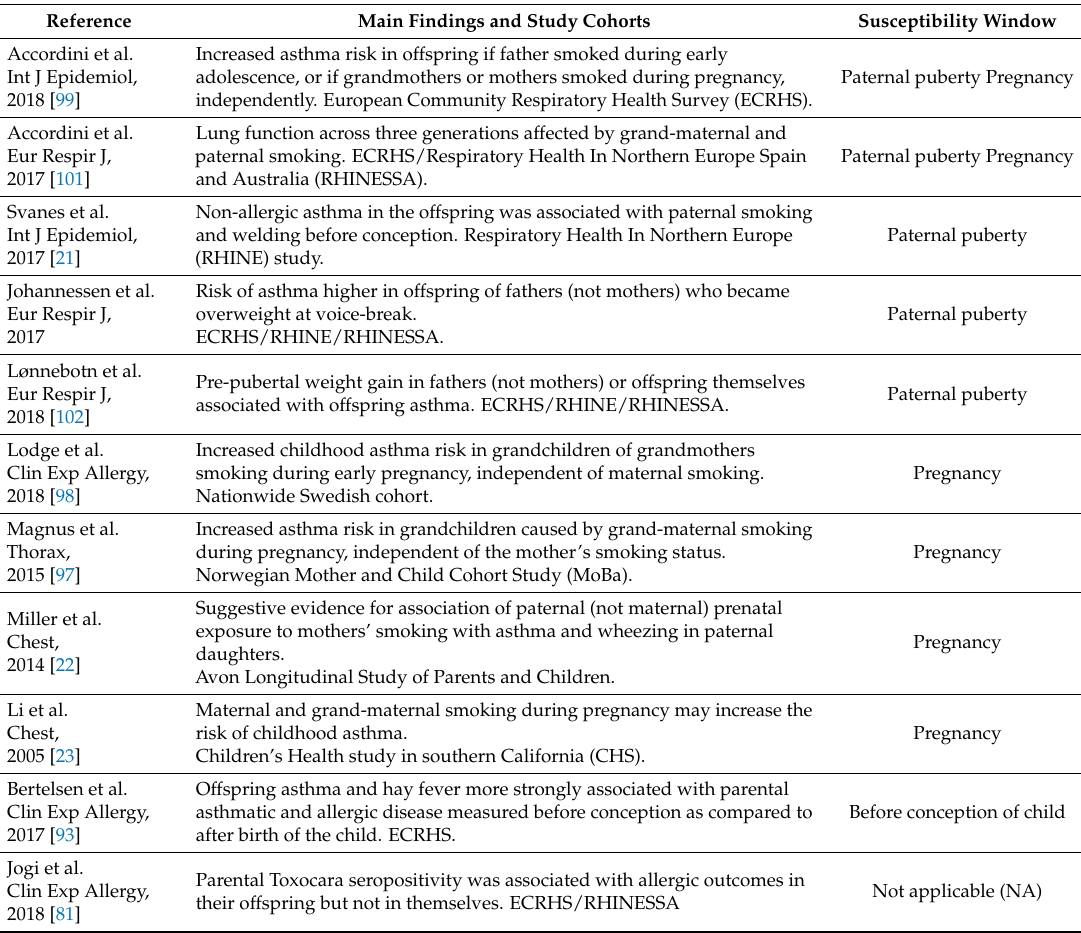
Table 1. Summary of intergenerational human studies related to asthma and